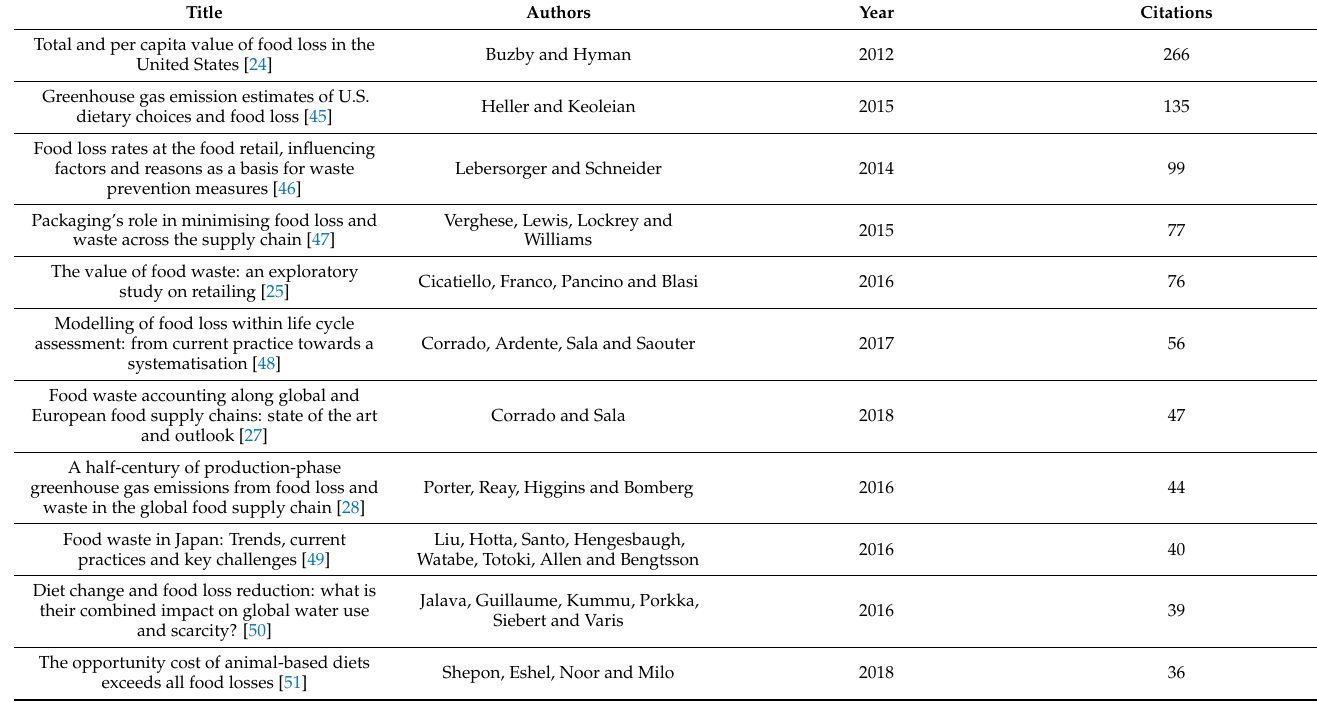
Table 2. Most cited documents.